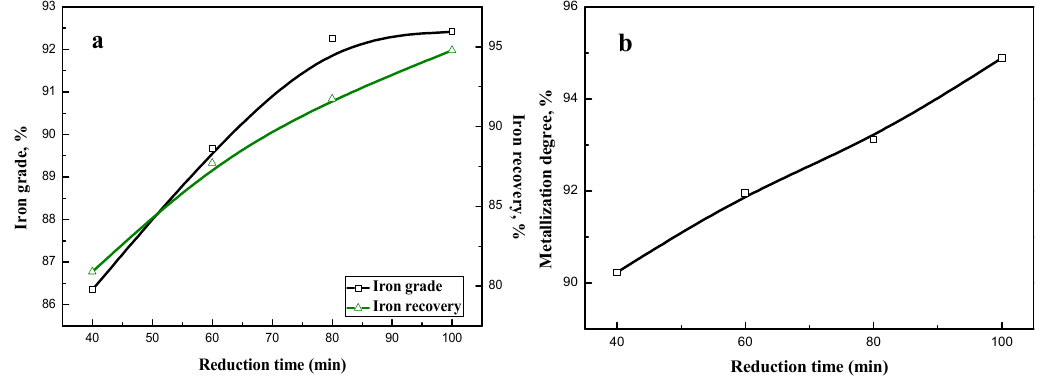
Figure 6. Effect of reduction time on iron grade and iron recovery of magnetic concentrate ( a ), and effect of reduction time on metallization degree of reduced briquettes ( b ) (borax dosage of 5%, reducing at 1050 °C, and grinding fineness (<0.044 mm) exceeding 68%).